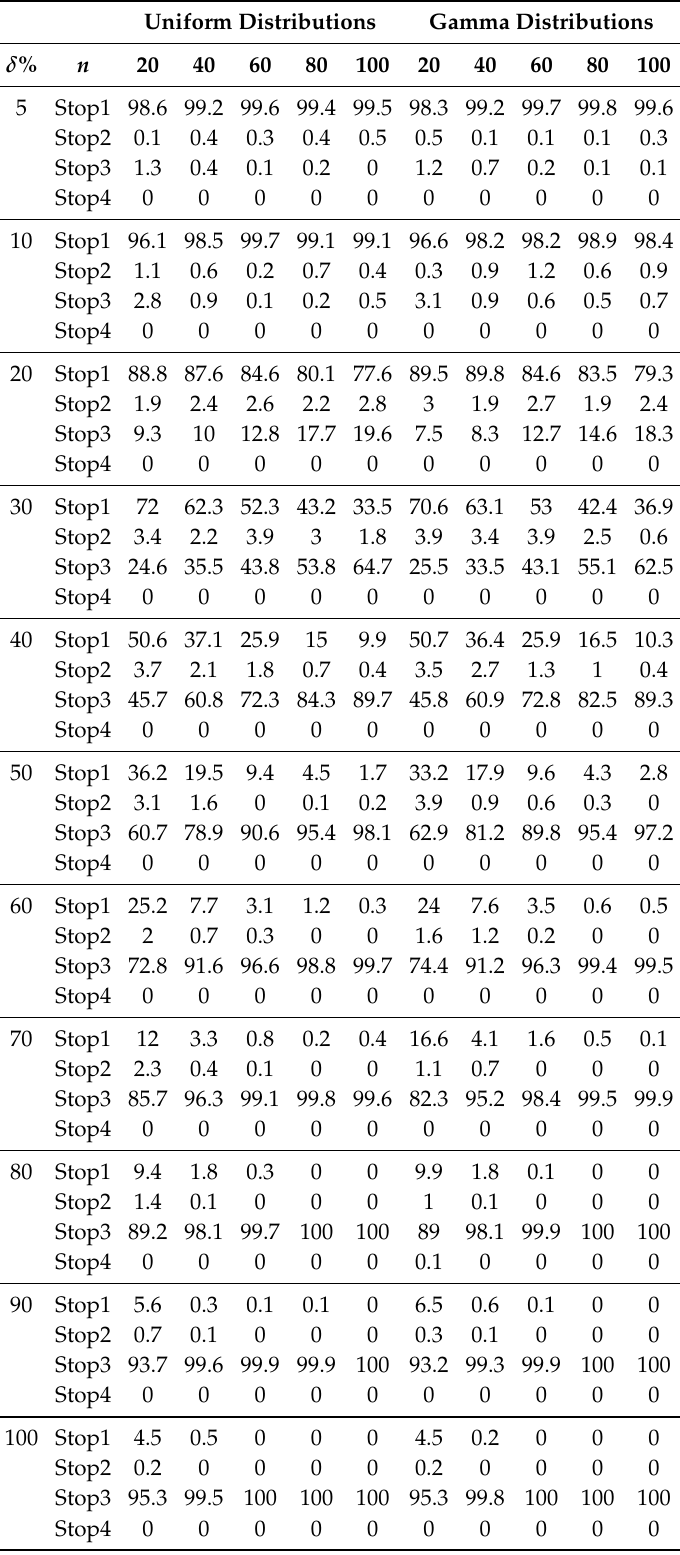
Table A8. Computational results for randomly generated instances with the ratio 5%:20%:5%:70% of the numbers of jobs in the subsets J 1 , J 2 , J 1,2 and J 2,1 of the job set J